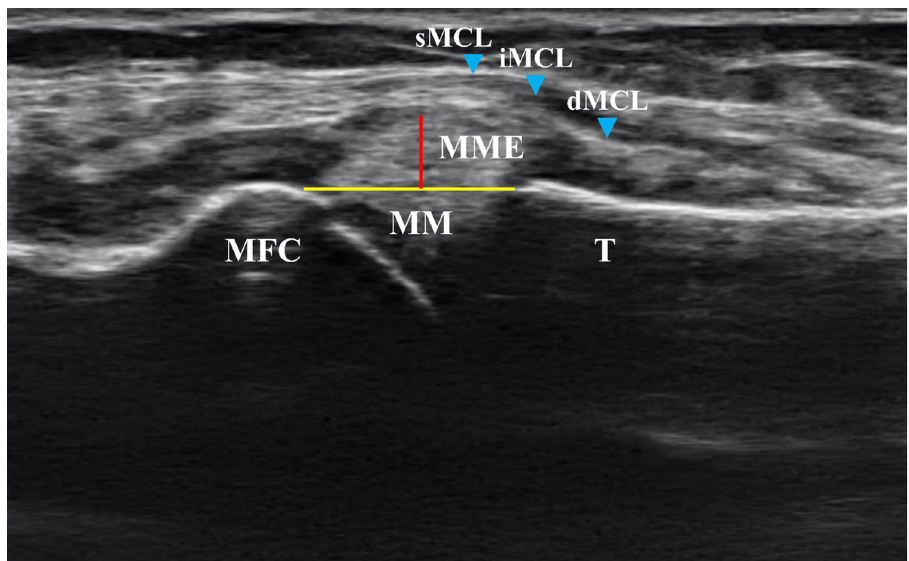
Fig 2. Definition of MME measurements. Longitudinal ultrasound images at the level of the MCL at the medial aspect of the knee joint. MME (red line) was measured as the distance between the outermost border of the medial meniscus and the line connecting the medial borders of the femur and tibia (yellow line). Abbreviations: sMCL (light blue arrowhead), superficial bundle of the medial collateral ligament (MCL); iMCL (light blue arrowhead), intermediate superficial bundle of the MCL; dMCL (light blue arrowhead), deep posterior bundle of the MCL; MME, medial meniscal extrusion; MM, medial meniscus; MFC, medial femoral condyle; T, tibia.